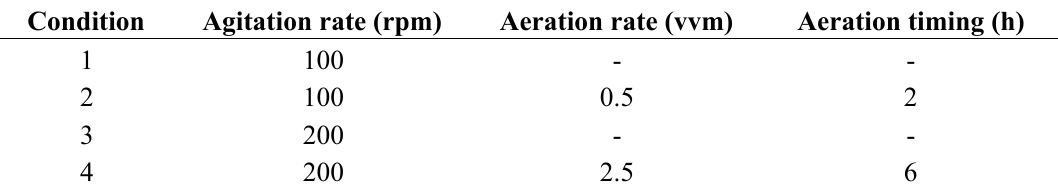
Table 1. Agitation and aeration conditions for the preliminary